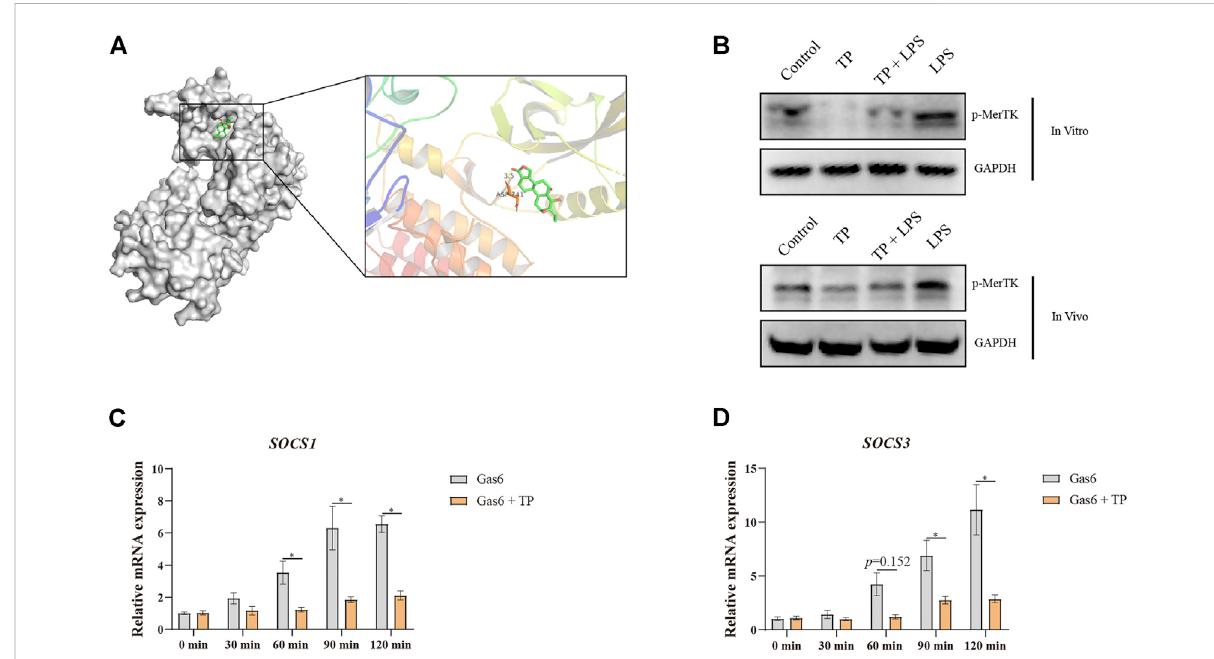
FIGURE 6 Macrophage MerTK might be the new target for TP. (A) Molecular docking of TP and MerTK (RCSB code: 7VAX) visualized with PyMOL. (B) Representative protein bands of p-MerTK in RAW264.7 cells (top panels) and mice (bottom panels) after TP and LPS treatment, with GAPDH as the loading control. The procedure of in vivo experiment was illustrated in Figure 1. In the in vitro experiment, TP (20 nmol/L) was preincubated 2 h before LPS (50 ng/ml). Twenty-4 hours after LPS, cells were collected for western blot analysis. (C,D) RAW264.7 cells were preincubated with TP (20 nmol/L) for 2 h and then stimulated with Gas6 (50 nmol/L). Cells were harvested at the indicated time points. The relative mRNA levels of SOCS1 and SOCS3 weredetectedbyqPCRwith Gapdh astheinternalcontrol( n =4).Resultswereexpressedasmeans±SEM.Statisticalanalysiswas performed using Two-way ANOVA followed by Tukey ’ s Multiple Comparison Test. p < 0.05 was considered to be statistically